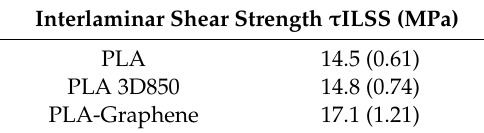
Table 5. Average ILSS test results of PLA, PLA 3D850 and PLA-Graphene. Standard deviation is depicted in